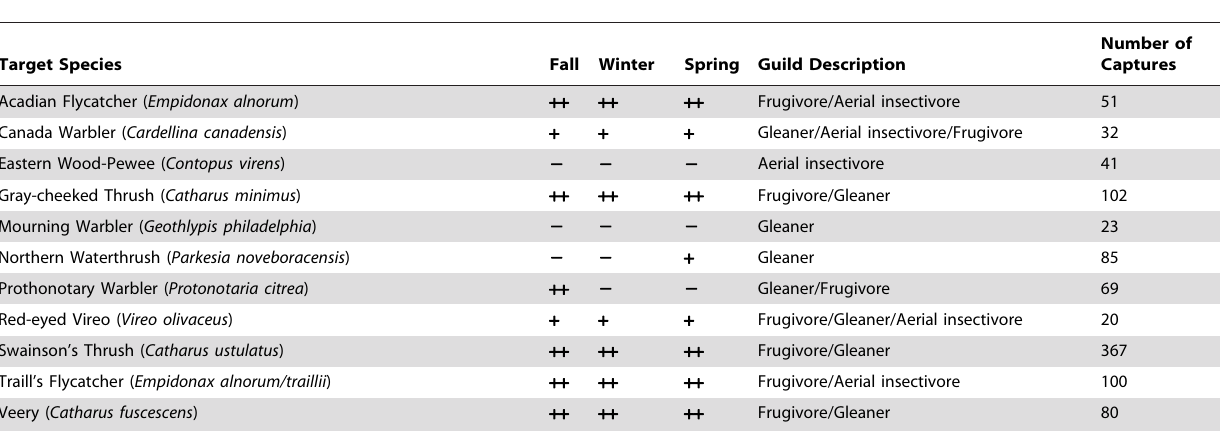
Table 1. The degree of frugivory of the study species while in tropical latitudes; ‘ + ’ indicates moderate frugivory, ‘ ++ ’ indicates high frugivory, ‘ 2 ’ indicates little to no